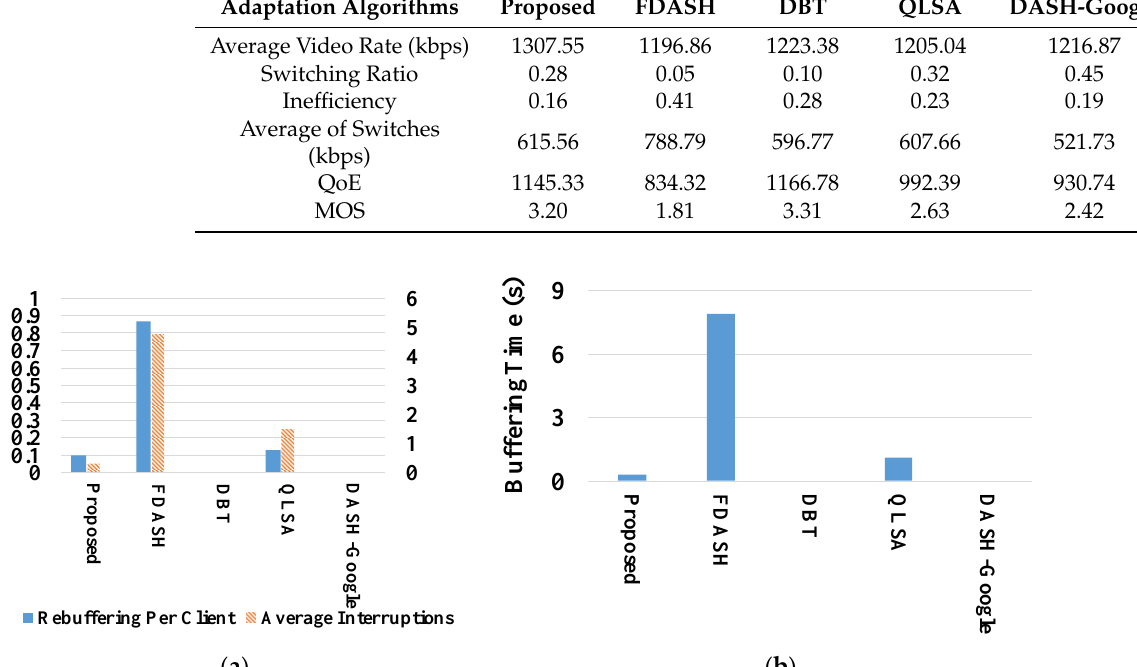
Figure 7. Comparison of ( a ) rebufferings per client, and average number of interruptions, and ( b ) average buffering time when the clients downloaded Dataset 1. The buffer size and segment duration were set to 15 s and 2 s, respectively.